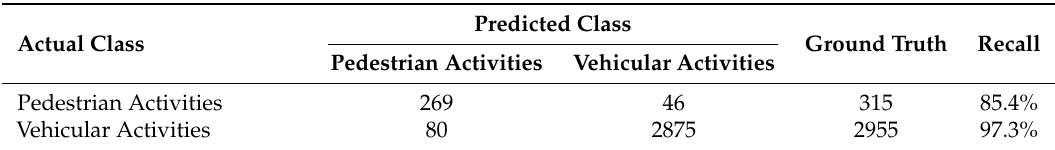
Table 5. Confusion matrix of vehicular activity detection.